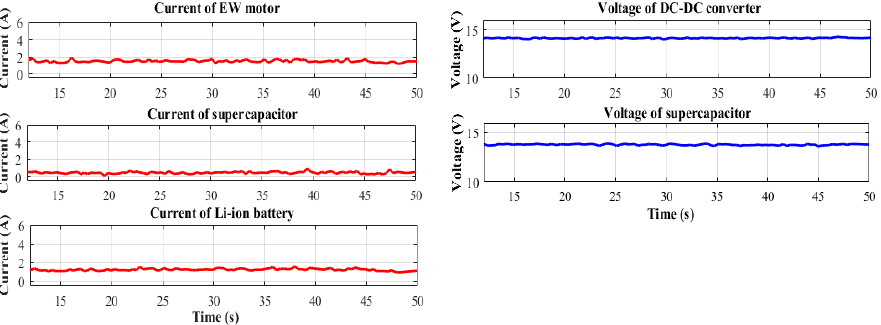
Figure 11. Experimental results for track-AB.